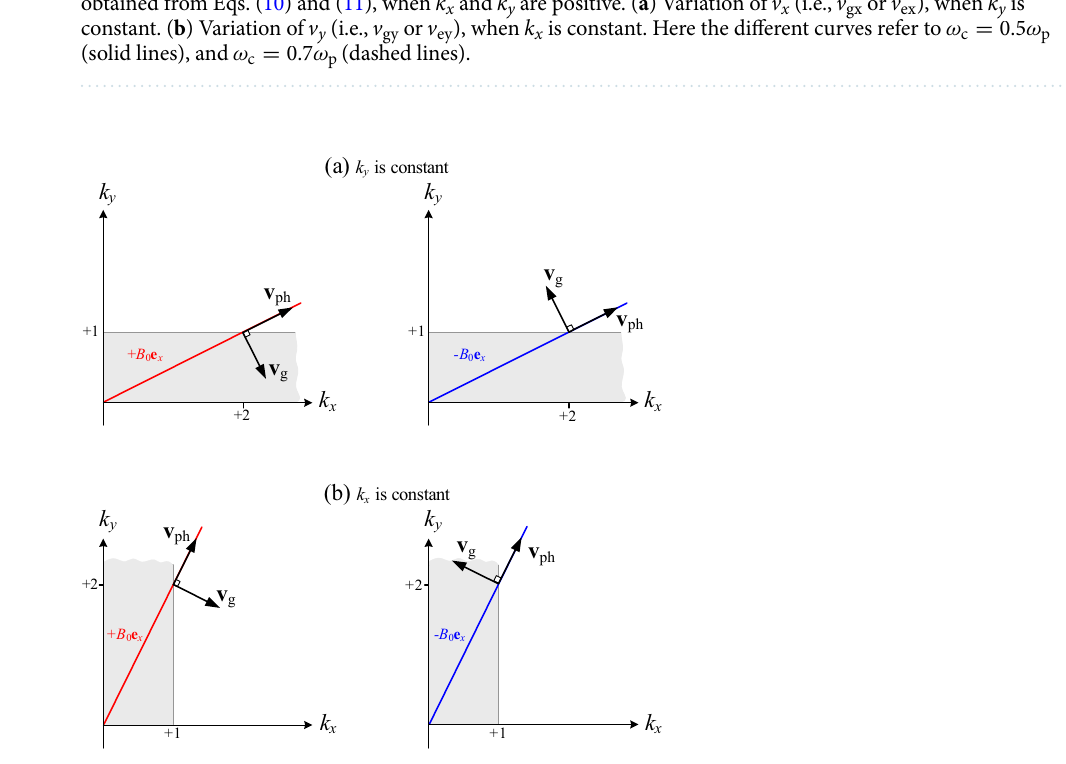
B 0 e x (left figures) and B 0 e x (right + − z -direction. Note that ±